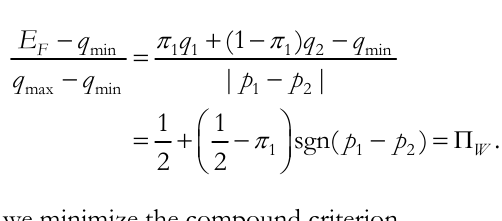
 for different values of p  